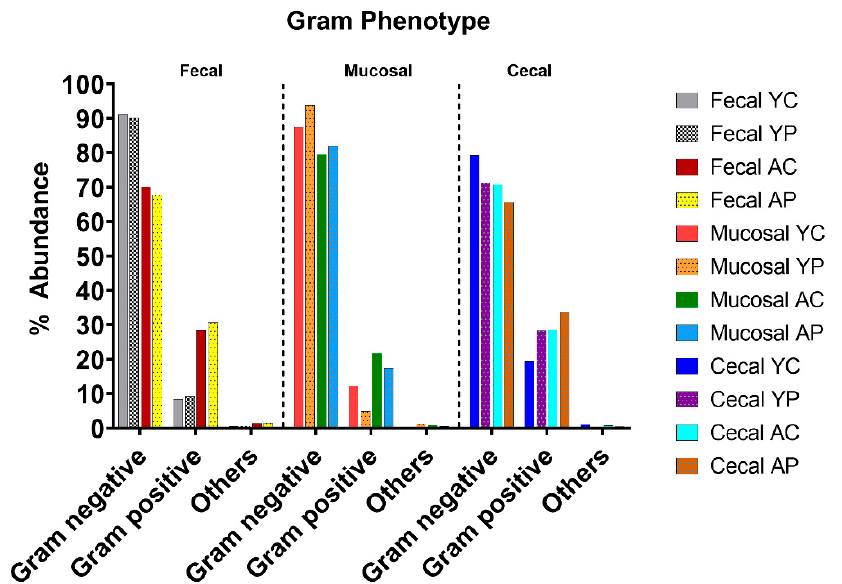
Figure 4. Gram-negative taxa differences between fecal, mucosal, and cecal samples in young and aging mice revealed by functional metagenomics analysis. (YC) Young control group, (YP) young probiotic group, (AC) aging control group, and (AP) aging probiotic group.